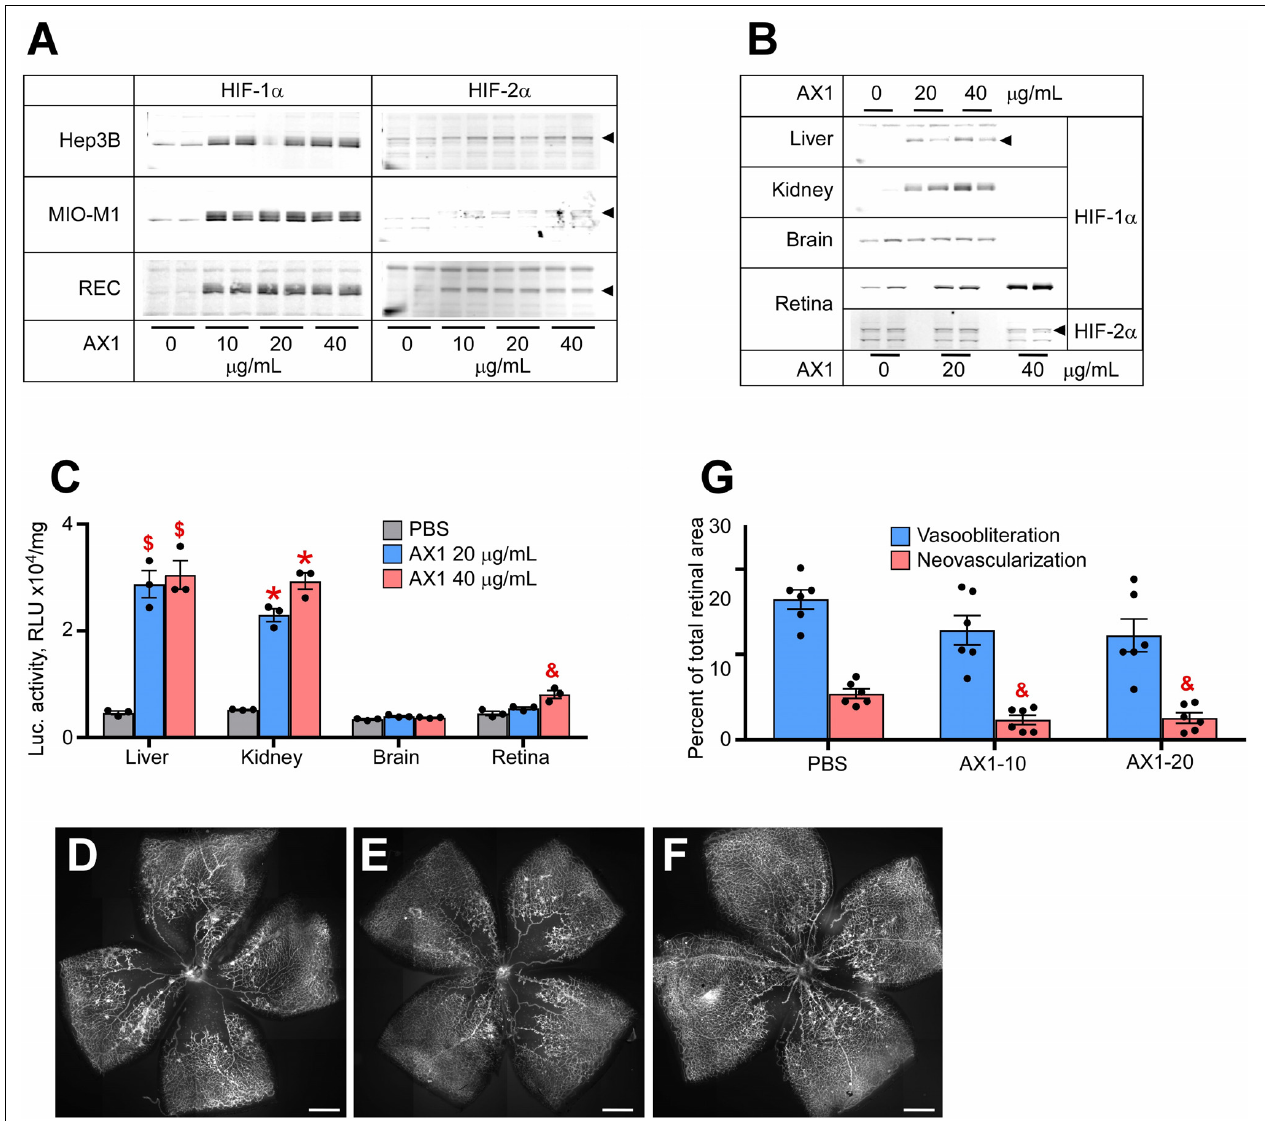
FIGURE 3 | Potency of AX1 in HIF stabilization and prevention of OIR. (A) Western blot analysis of HIF-1 α /2 α protein levels in three types of cultured cells treated overnight with the indicated concentrations of AX1. (B) Western blot analysis of HIF-1 α /2 α protein levels in the organs of P8 mouse pups 3 h after injections with PBS (control) or indicated doses of AX1. (C) Luciferase activity in tissue homogenates of P8 Luc-ODD mouse pups 3 h after injections of PBS (control) or indicated doses of AX1, n = 3 for each experimental condition. (D–F) Representative retinal flatmounts of the P17 mouse pups subjected to the OIR model and treated with PBS (D) , 10 µ g/g (E) or 20 µ g/g (F) of AX1, scale bar = 500 µ m. (G) Quantitative analysis of retinal flatmount images represented in panels (D–F) for areas of vasoobliteration and neovascularization, n = 6 for each experimental condition. P values are presented as follows, * ≤ 0.0001; $ ≤ 0.005; & ≤ 0.01; # ≤ 0.05, and represent statistical difference vs PBS